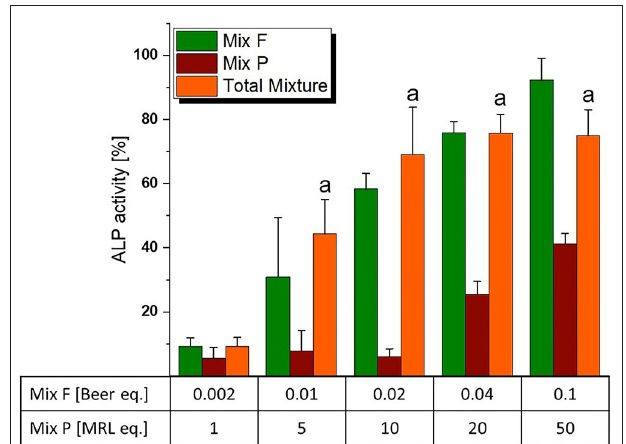
FIGURE 6 | Estrogenicity of the total mixture (comprised of “Mix F” – hop flavonoid mixture and “Mix P” – pesticide mixture), as measured with ALP assays. Values were scaled to the solvent control (0%) and the positive control (1nM E2, 100%) and are expressed as means ± SD of at least five independent experiments. Significant differences of the total mixture to the solvent control were calculated by one-way ANOVA, followed by Fisher LSD post-hoc testing, and are indicated by “a” ( p <